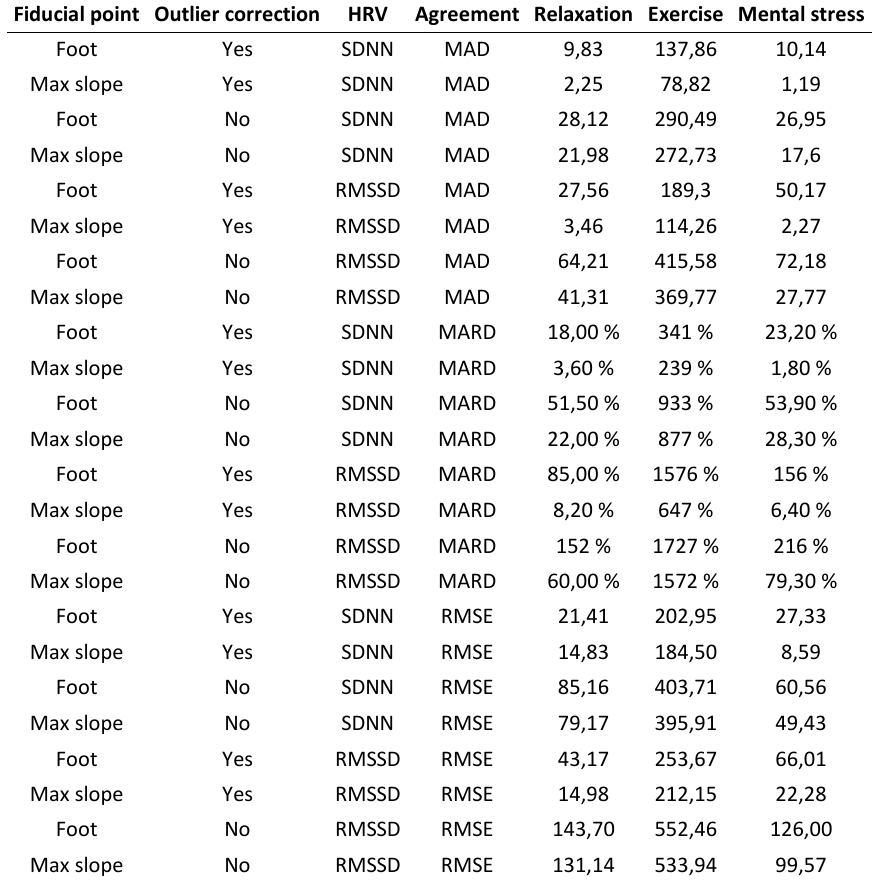
Table 1. Summary of agreement between HRV derived from ECG and PPG for each type of activity, depending on PPG fiducial point selection with and without correction of outliers. The agreement is represented as median absolute deviation (MAD), median absolute relative deviation (MARD) and the root mean square error (RMSE).